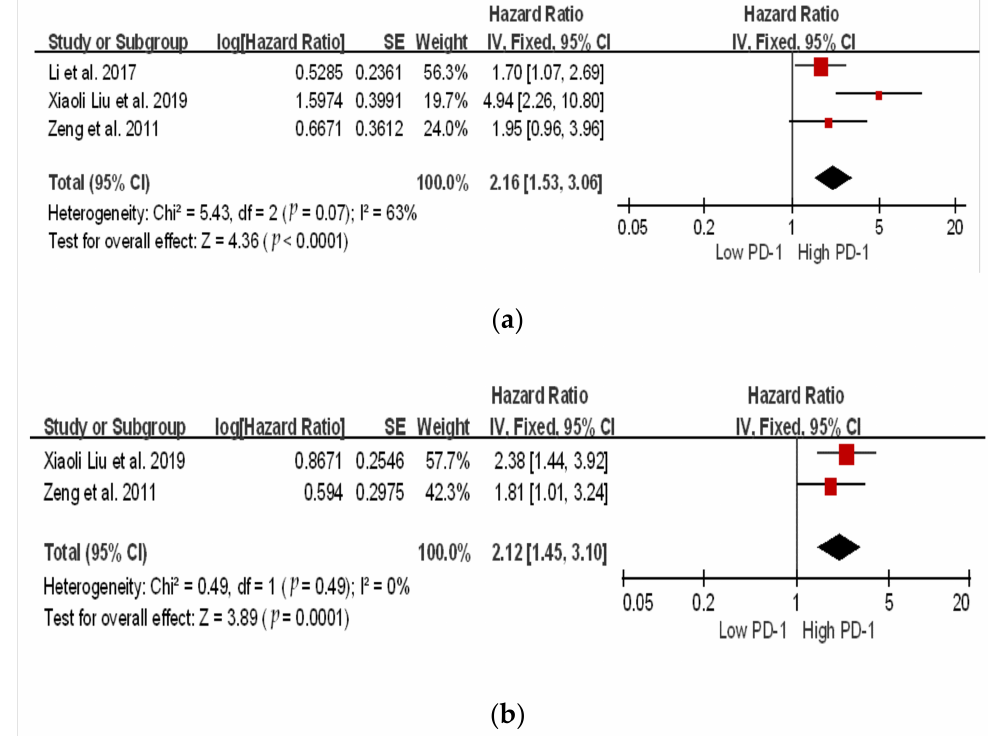
Figure 3. Subgroup hazard ratios assessing PD-1 expression. ( a ) Overall survival and ( b ) disease-free survival in patients with hepatocellular cancer [26,27,29]. The location of the square shows the risk ratio, while the size of the square represents the individual effect of research; the black line depicts the study’s confidence interval at 95%; the edge of the diamond denotes the 95% confidence interval for the pooled hazard